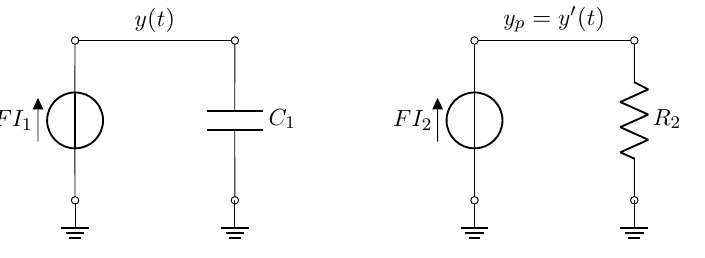
Figure 3. Circuits to generate the values of y(t) and y’(t)